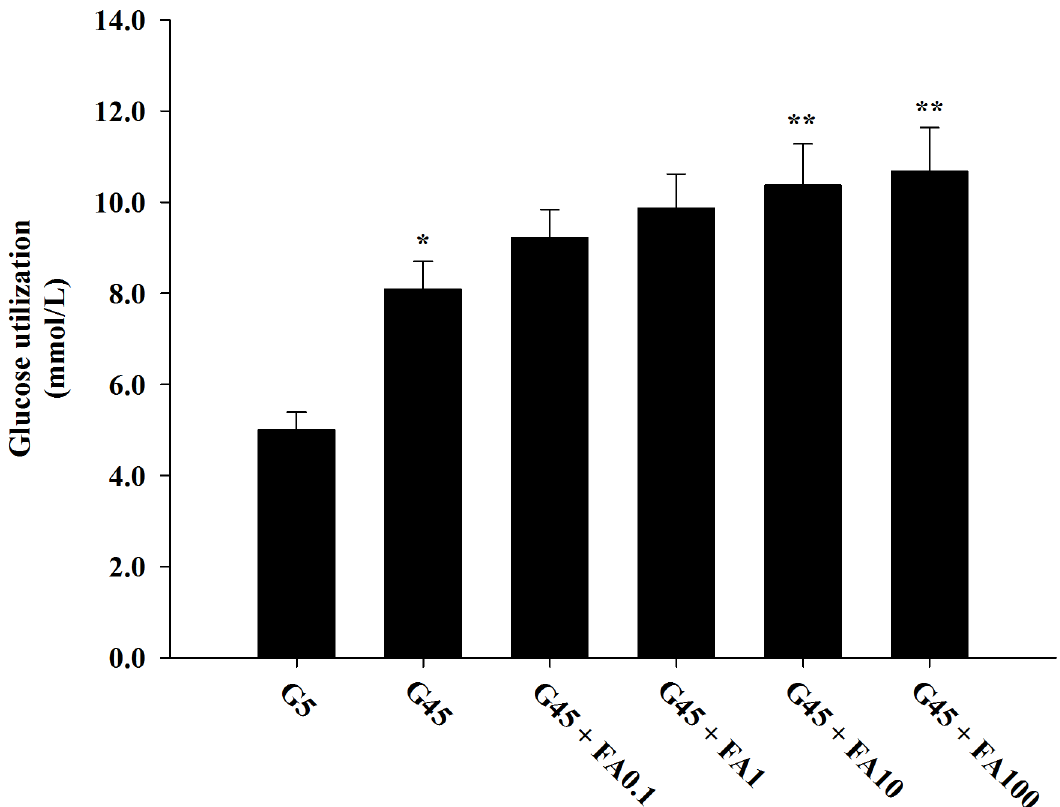
Fig 3. The effects of ferulic acid (0.1 – 100 μ M) on glucose utilization in erythrocytes treated with 45 mM glucose. The results are expressed as mean ± SEM ( n = 6). * p < 0.05 compared to 5 mM glucose (G5) and ** p < 0.05 compared to 45 mM glucose (G45) treatments.